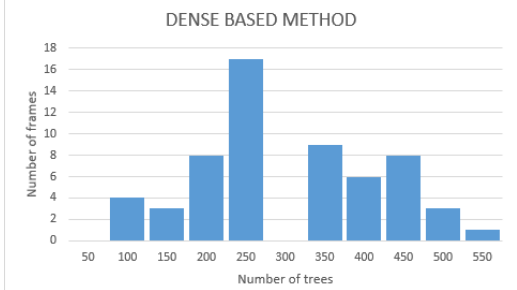
Figure 11 Graph Depicting Number of Trees Vs Number of Frames from Dense Based Method The figure 11 shows the graph of number of frame vs number of trees counted through dense method on 60 frames.